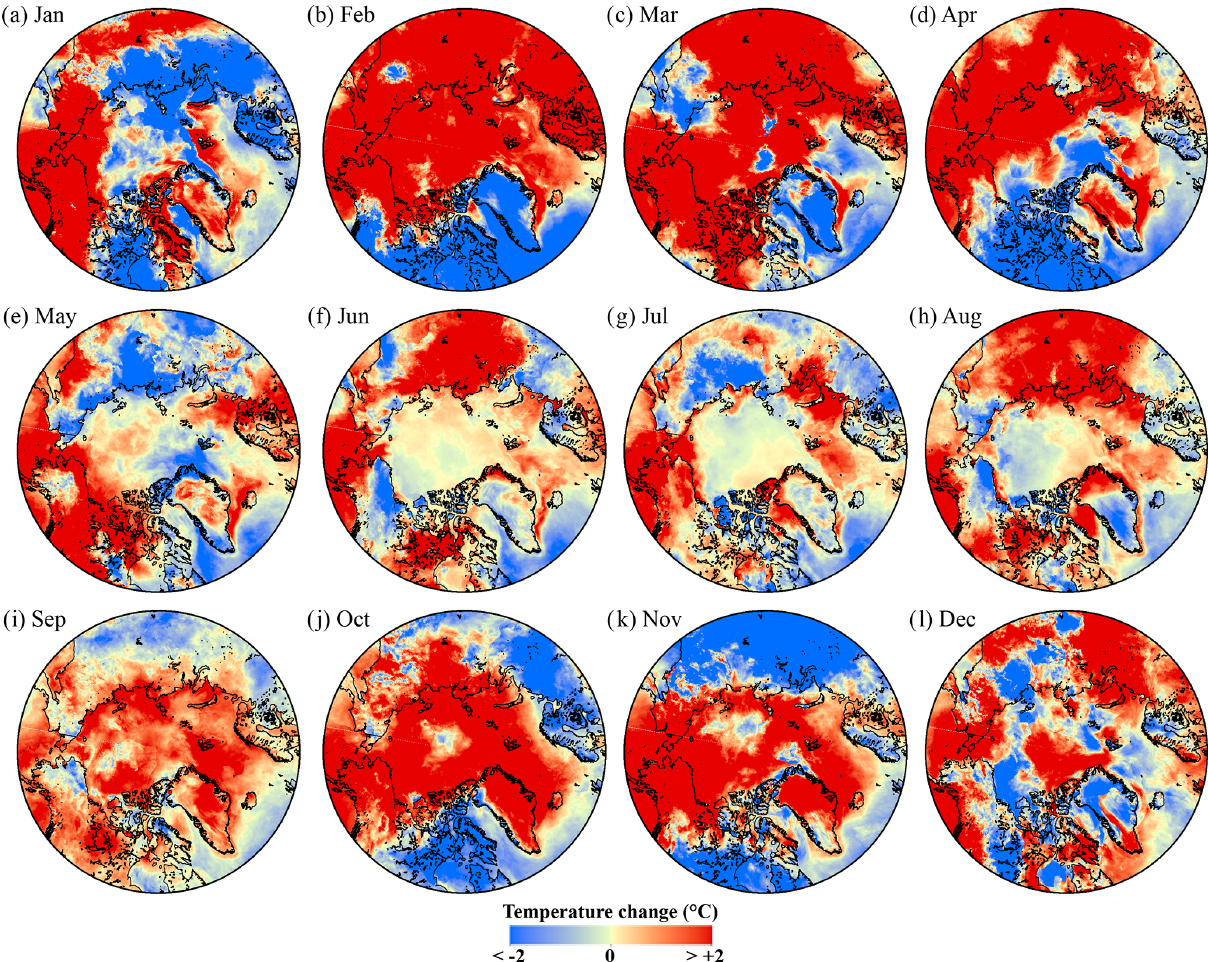
Figure 8. Trends in monthly 2m temperature from 2004–2019 in (a) January, (b) February, (c) March, (d) April, (e) May, (f) June, (g) July, (h) August, (i) September, (j) October, (k) November, and (l)